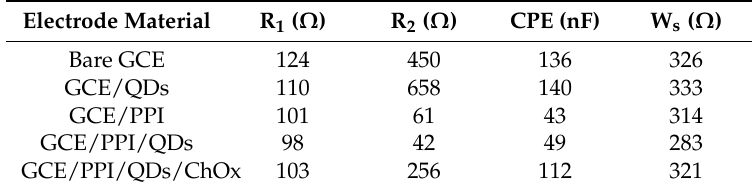
Figure 3. Nyquist plot of GCE (i); GCE/QDs (ii); GCE/PPI (iii), GCE/PPI/QDs (iv); and GCE/PPI/QDs/ChOx (v) in 10 mM [Fe (CN) 6 ] 3 − /4 − /0.1 M KCl redox probe in the frequency range of 10 3 Hz to 1 Hz. Insert: Corresponding equivalent circuit obtained from the Nyquist plot. Table 1. Impedance parameters obtained from circuit fitting of Nyquist plots (Figure 3) during electrode modification and biosensor design. R 1 = solution resistance, R 2 = charge transfer resistance, CPE = constant phase element, W s = Warburg